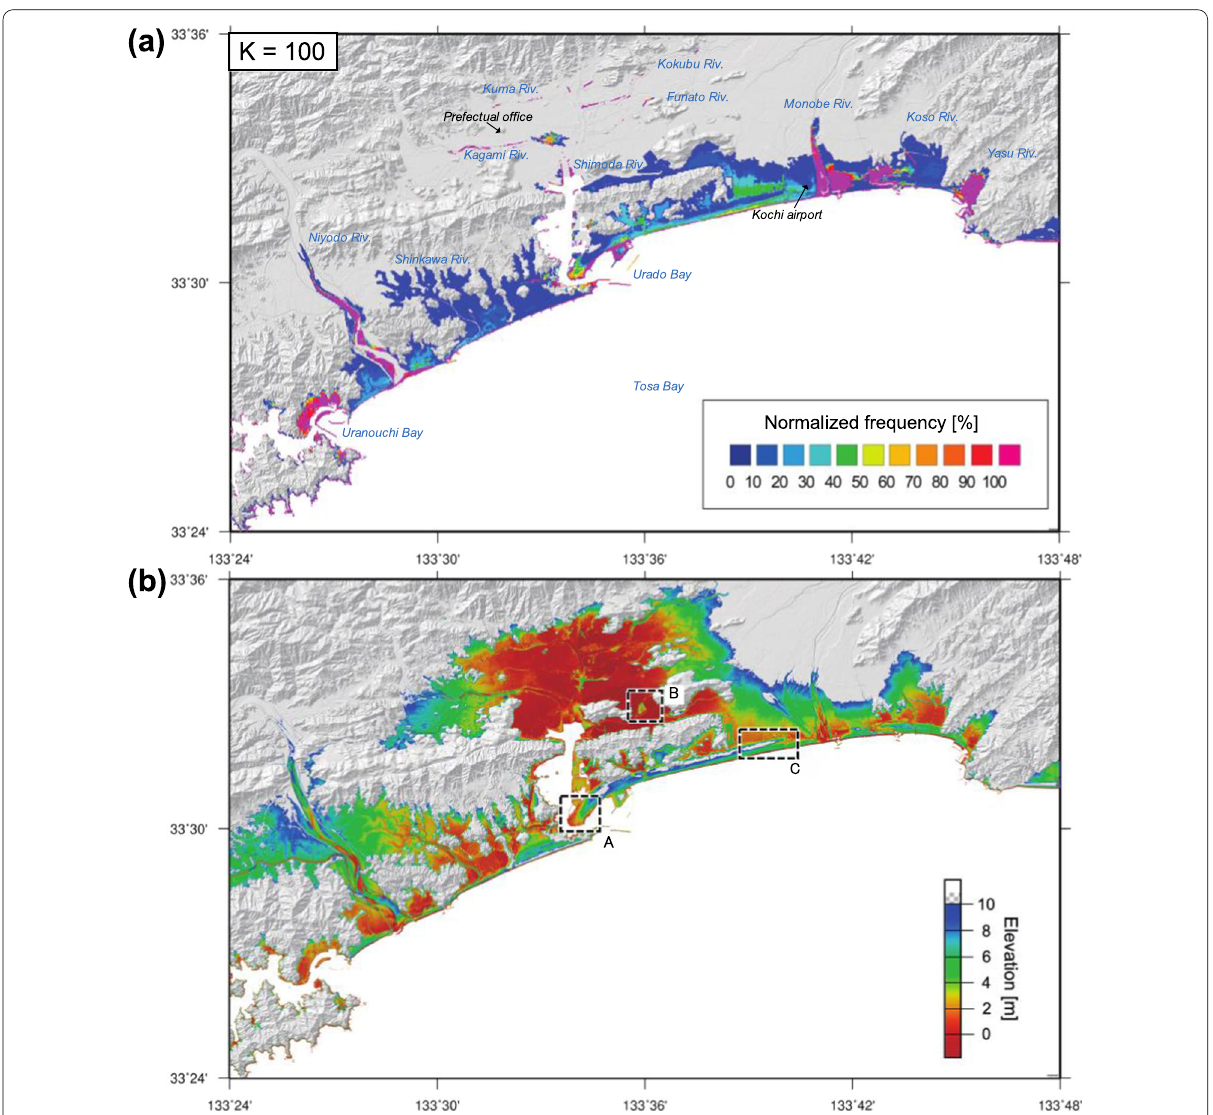
Fig. 7 Real-time tsunami inundation risk maps for Kochi city. a Real-time tsunami inundation risk map for Kochi city ( K topography map (Geospatial Information Authority of Japan). Colors indicate normalized frequency of inundation from the 100 tsunami inundation calculations. b Elevation map (Geospatial Information Authority of Japan). Dotted rectangles indicate areas mentioned in the